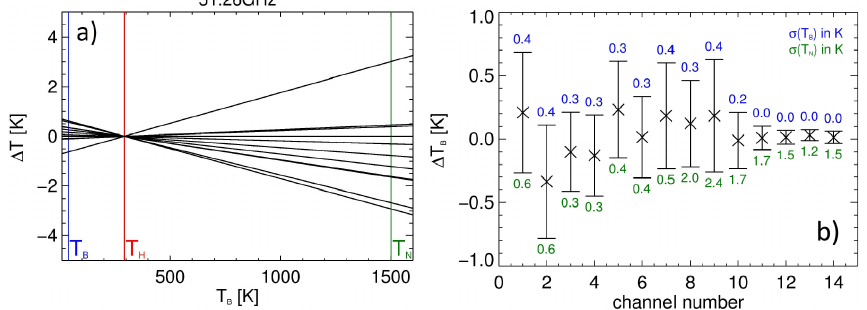
Fig. 6. (a) Impact of variations in noise diode temperature T N on T b measurements for the 51.26GHz channel. Vertical lines mark the mean brightness temperature T b =38.4K, the ambient target temperature T H =293.1K, and the average noise diode temperature T N =1501.3K. The reference for 1T b is the first calibration on 10 November 2011 performed with HATPRO-G2 at the Jülich Research Center. (b) Repeatability of the LN 2 calibration. The mean difference 1T b from the reference calibration (first calibration on November 10) and standard deviation σ(T b ) (error bars) of 11 LN 2 calibrations is given for all HATPRO-G2 channels. The colored numbers give the standard deviations σ(T N ) and σ(T b )